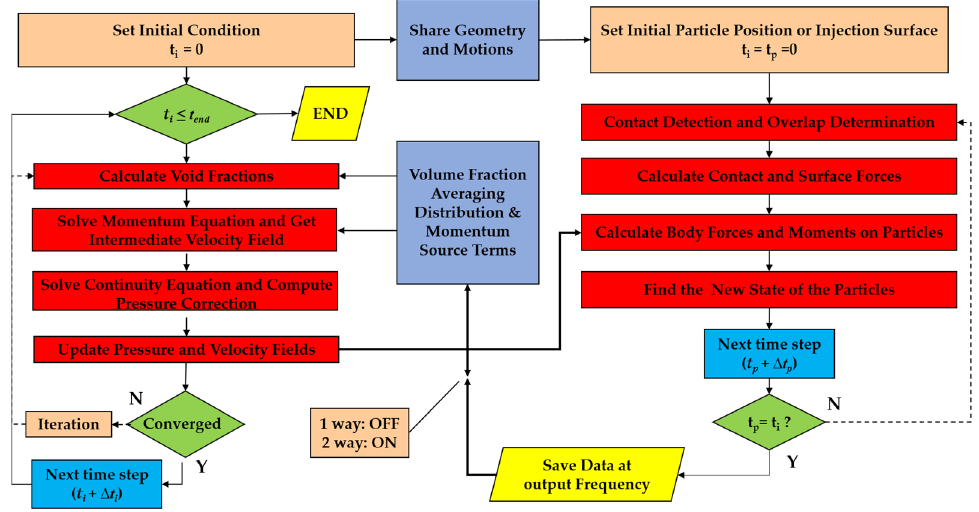
Figure 4. Flow chart for the model solution.